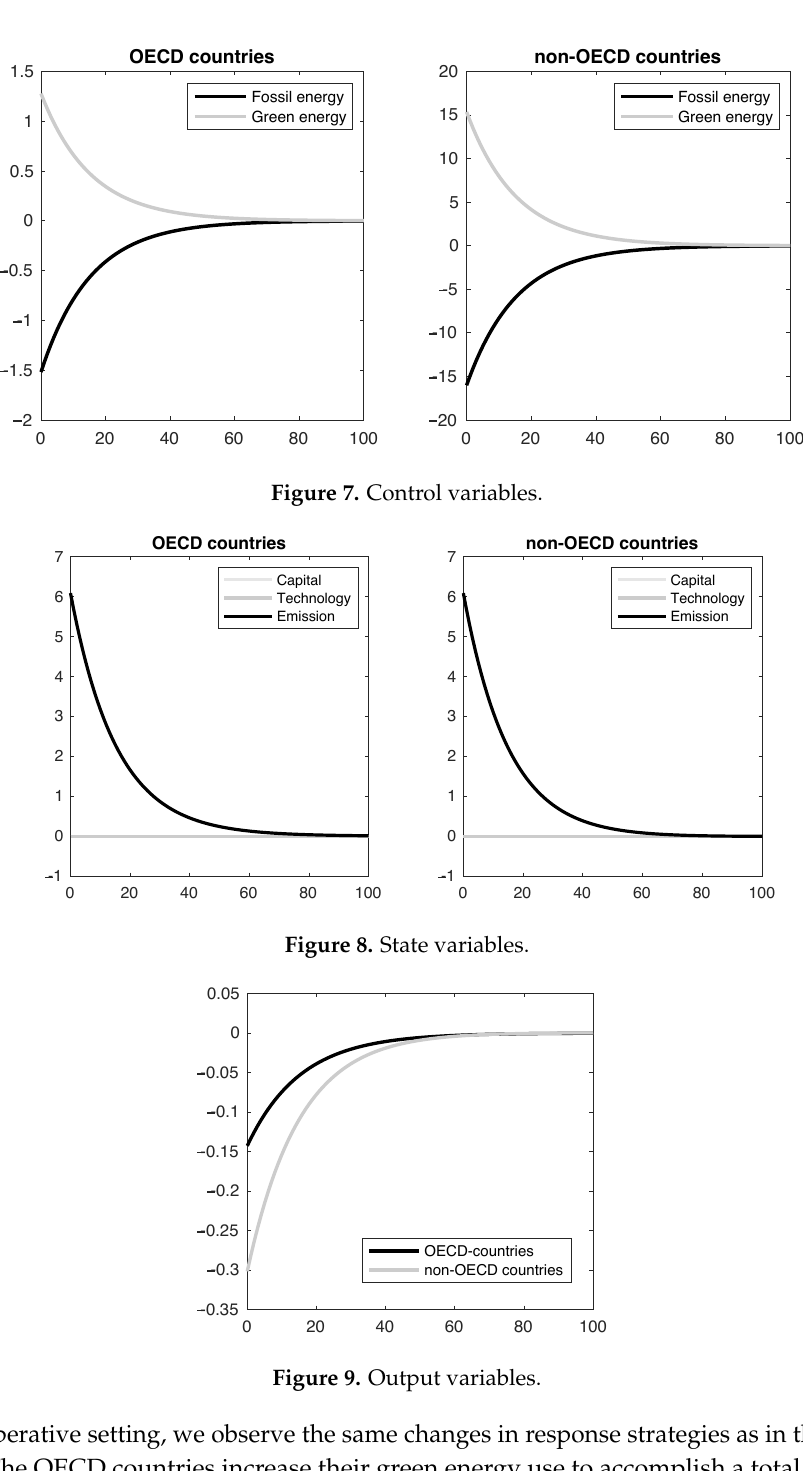
Figure 9. Output variables.